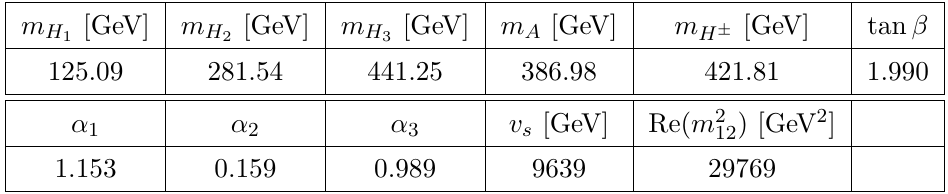
Table 32 . BP15 N2HDM-I input